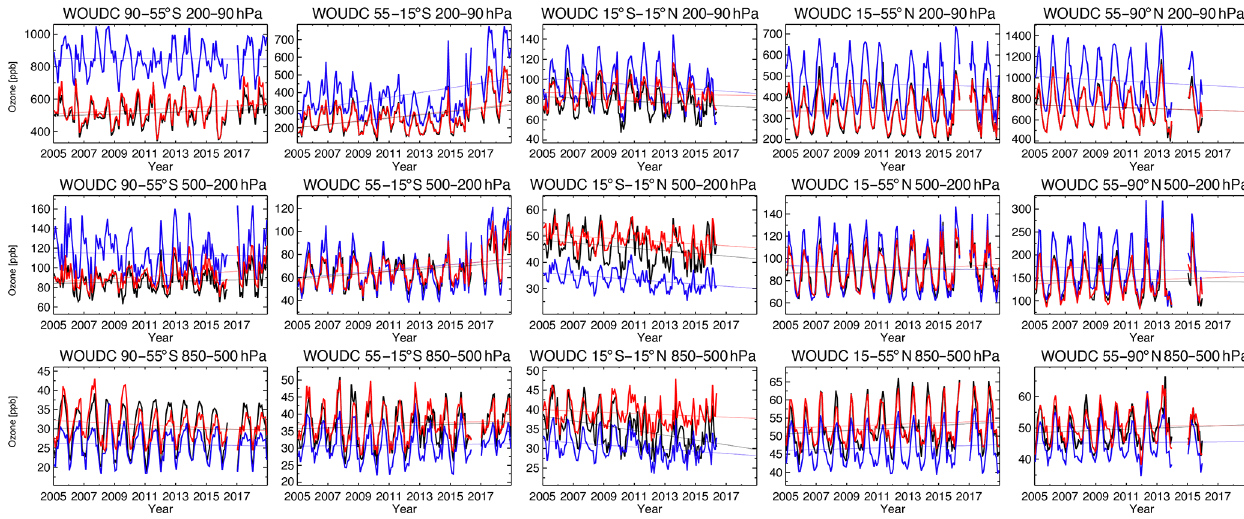
Figure 2. Time series of the monthly mean ozone concentration obtained from ozonesondes (black), the control run (blue), and reanalysis (red) averaged between 850–500hPa (lower row), 500–200hPa (center row), and 200–90hPa (upper row). From left to right, the results are shown for the SH high latitudes (55–90 ◦ S), SH midlatitudes (15–55 ◦ S), the tropics (15 ◦ S–15 ◦ N), NH midlatitudes (15–55 ◦ N), and NH high latitudes (55–90 ◦